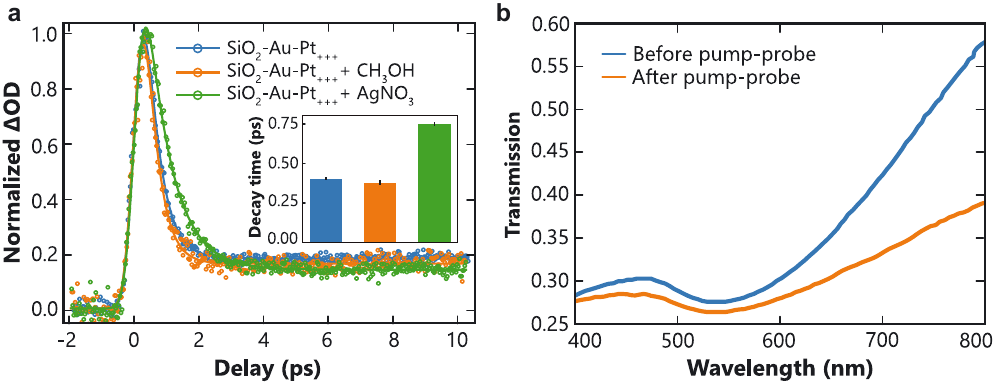
–Au–Pt +++ aqueous solution with 2 –Au–Pt +++ –AgNO solution before and after 2 3